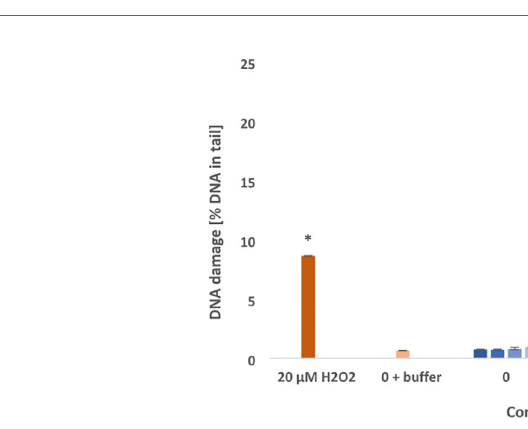
FIGURE 4 | Oxidative damage to purines in DNA. Oxidative damage to DNA purines in human PBMCs treated with TBBPA, TBBPS, 2,4,6-TBP and PBP at the concentration of 0.01 µg/mL, 0.1 µg/mL and 1 µg/mL for 24 h. DNA damage was measured as the percentage of DNA in the comet tail using the enzyme hOGG1 and the alkaline version of the comet assay. The mean ± SD was calculated for 3 experiments (3 blood donors). Statistically different from negative control at *P<0.05. Statistical analysis was conducted using one-way ANOVA and a posteriori Tukey